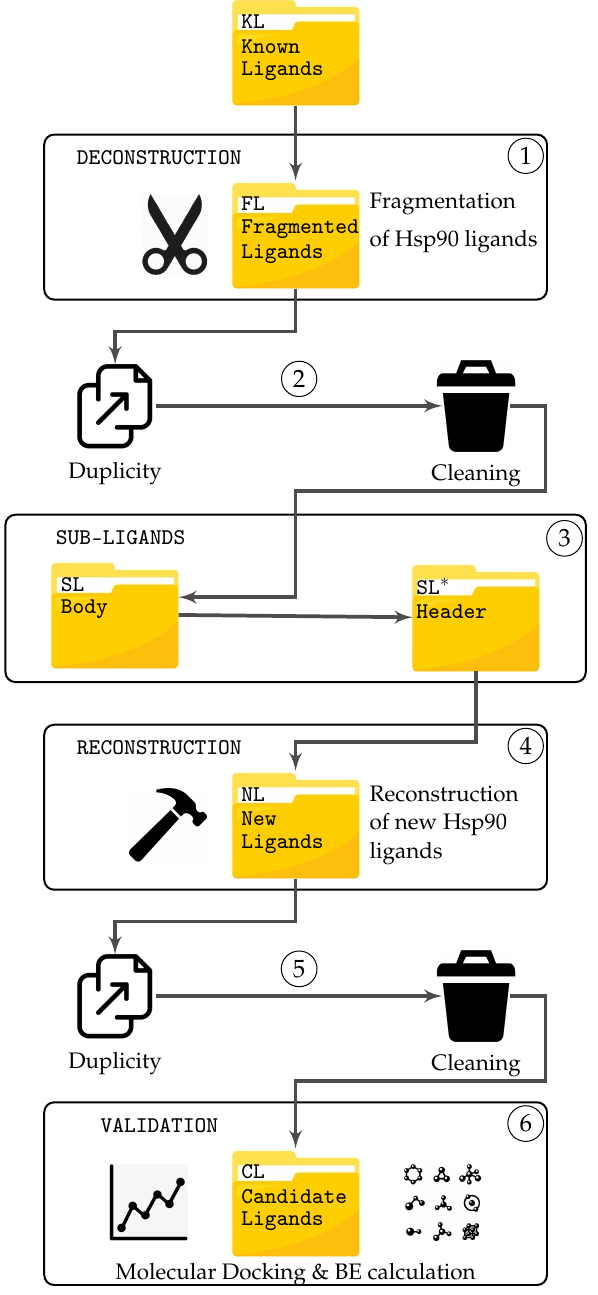
Figure 1. Flow chart of the deconstruction-reconstruction approach applied to HSP90 ligands. Stage 3. Sub-Ligands. The folder SL* contains all sub-ligands obtained in the previous stage. Each sub-ligand that includes an asterisk identifier indicates that it contains a broken bond. Another folder called SL contains each sub-ligand without the asterisk identifiers. In this set, we have the same sub-ligands from SL*, but without the identifiers. We recall that each of these folders contain N SL